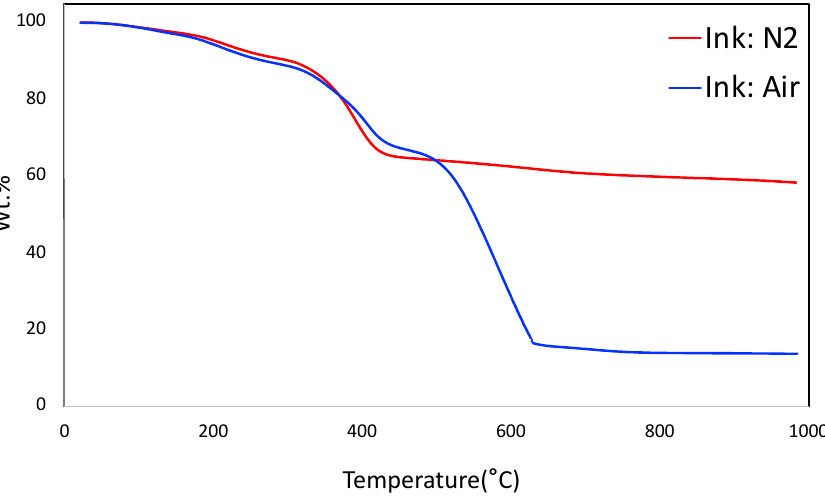
Figure 3. Thermogravimetric analysis (TGA) of ink under N 2 and air.